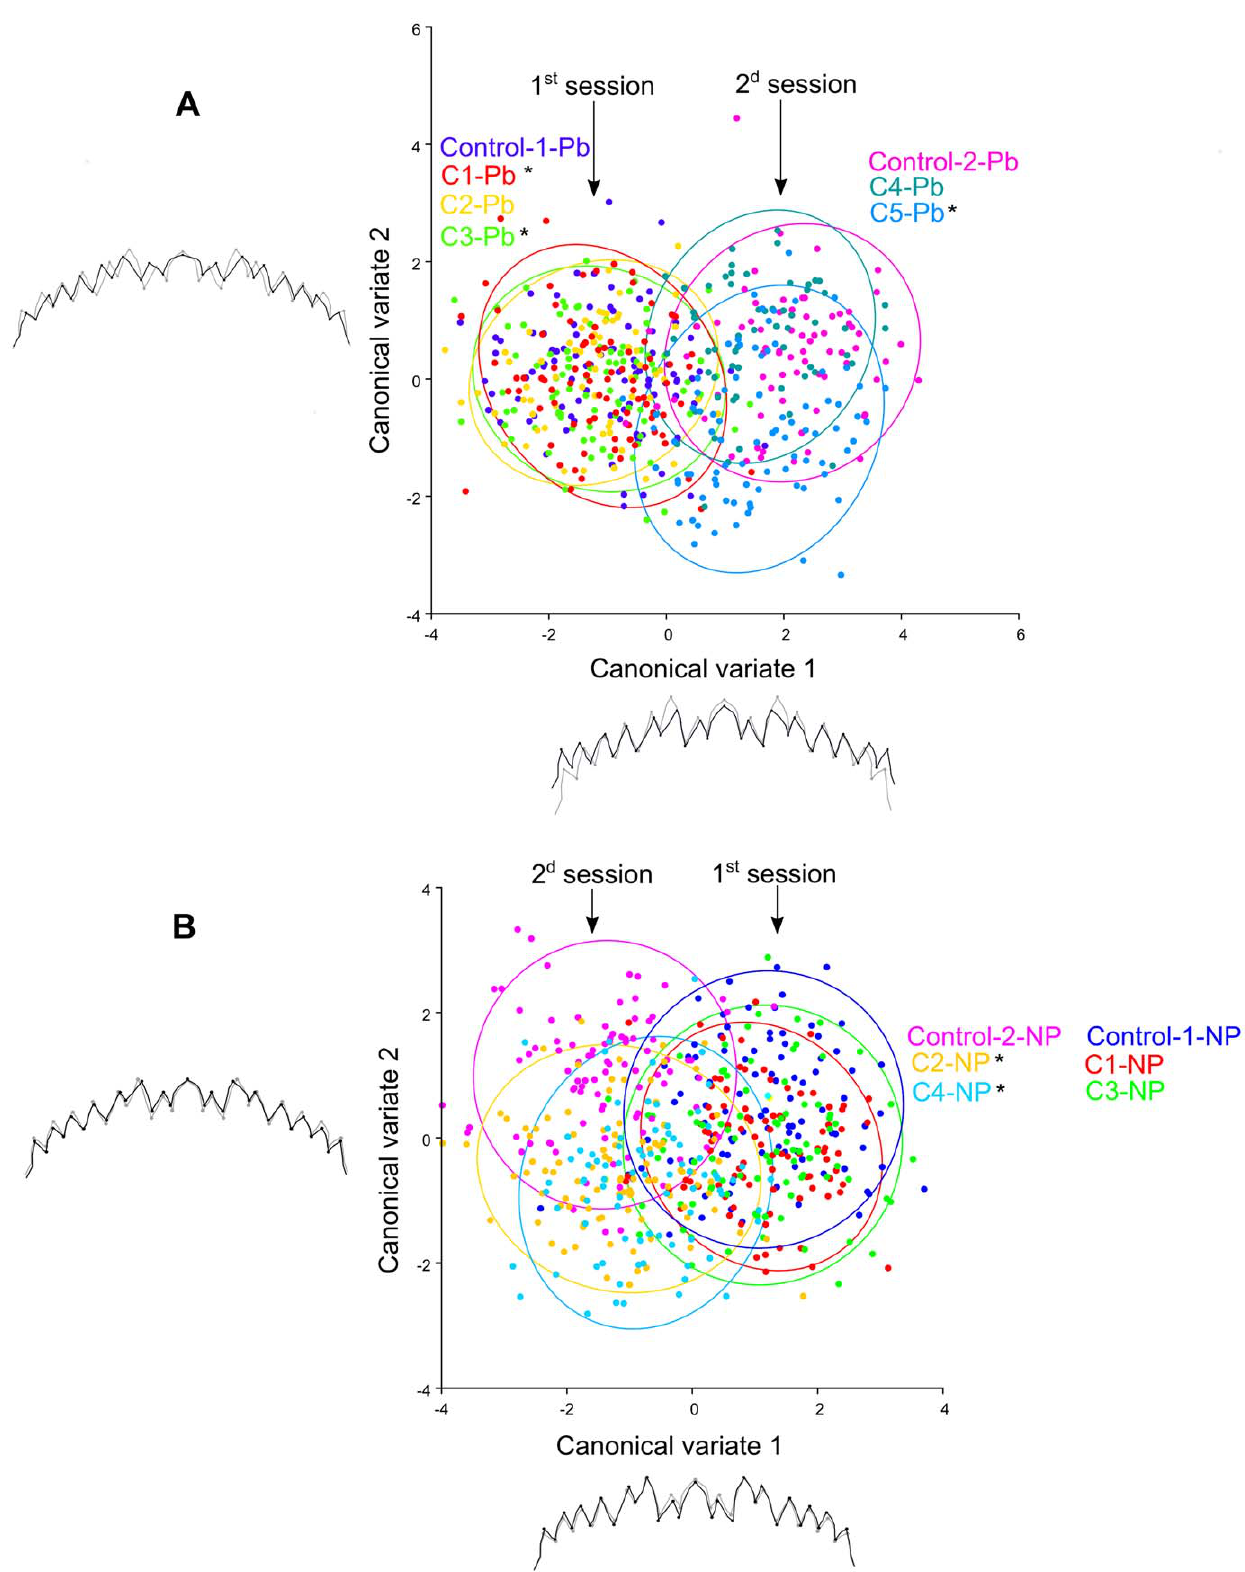
Figure 6. CVA showing the two discrimination vectors for lead and 4-NP bioassays and the associated patterns of mentum variation. Lead bioassays (A) and 4-NP bioassays (B). In grey extreme indivuals in negative side, in black extreme indivuals in positive side. *: Procuste distance significantly different from the control group (Permutation test, p , 0.05).